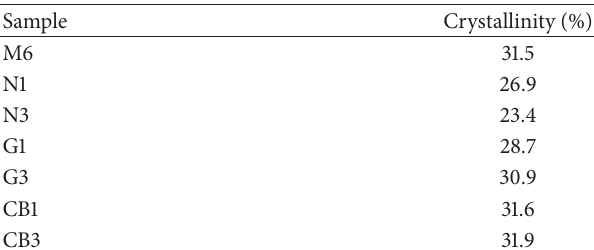
Table 4: Degree of nanocomposite crystallinity by calculating the area under the peak of XRD